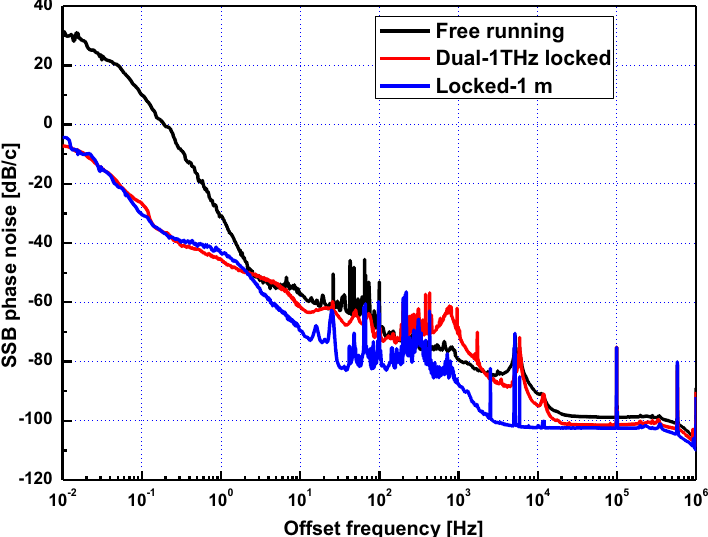
Fig. 4 The residual phase noise of the terahertz signal distribution system in conditions of free-running spool fiber link, phase-locked spool fiber link, and phase-locked 1 m short fiber,